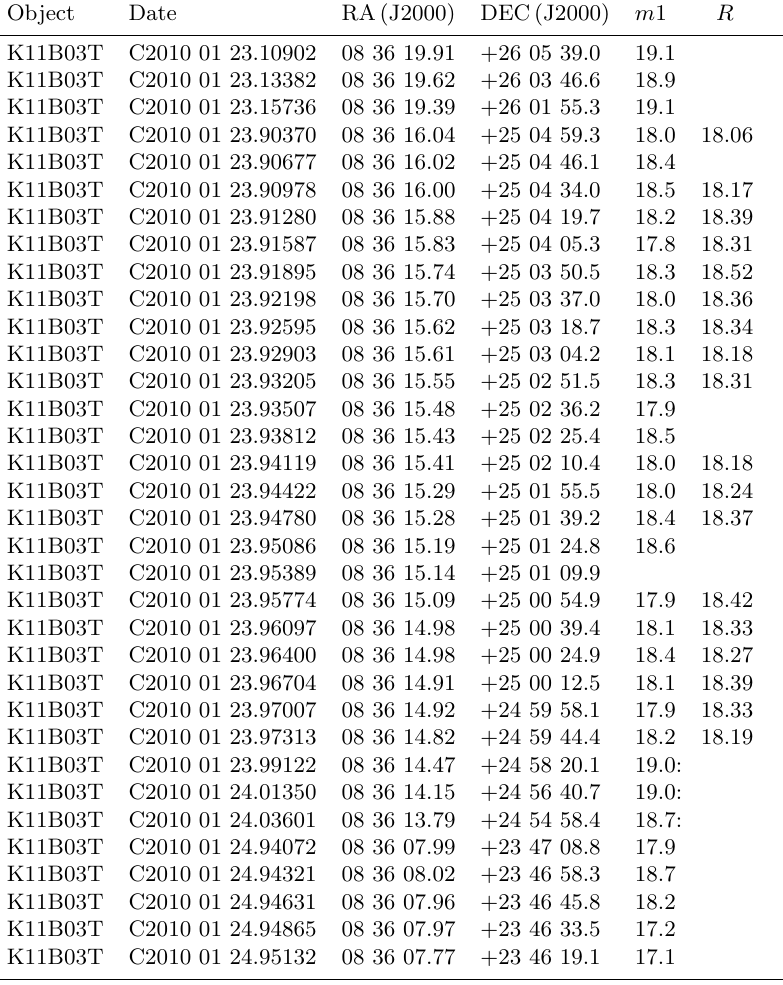
Table 5. Astrometric and photometric data for 2010 BT3 obtained at the Mol˙etai Observatory